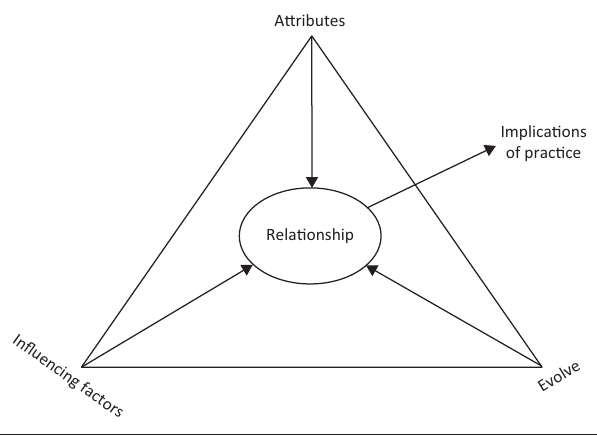
FIGURE 1: Connecting the confusion between data and information